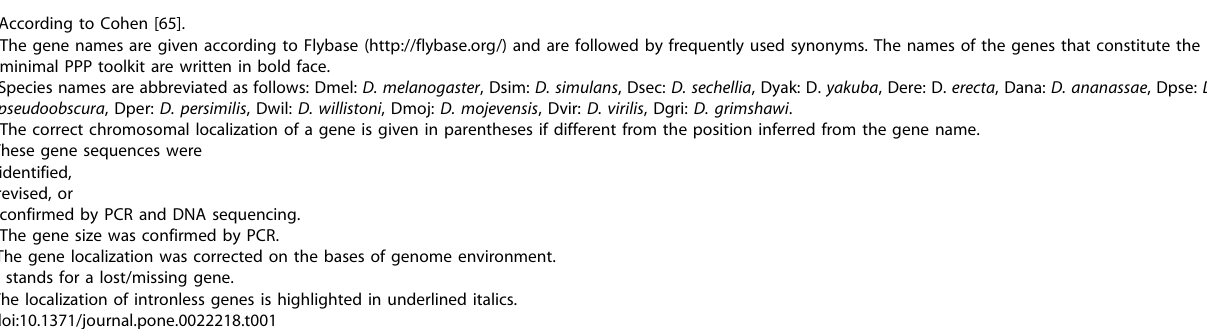
Classification a